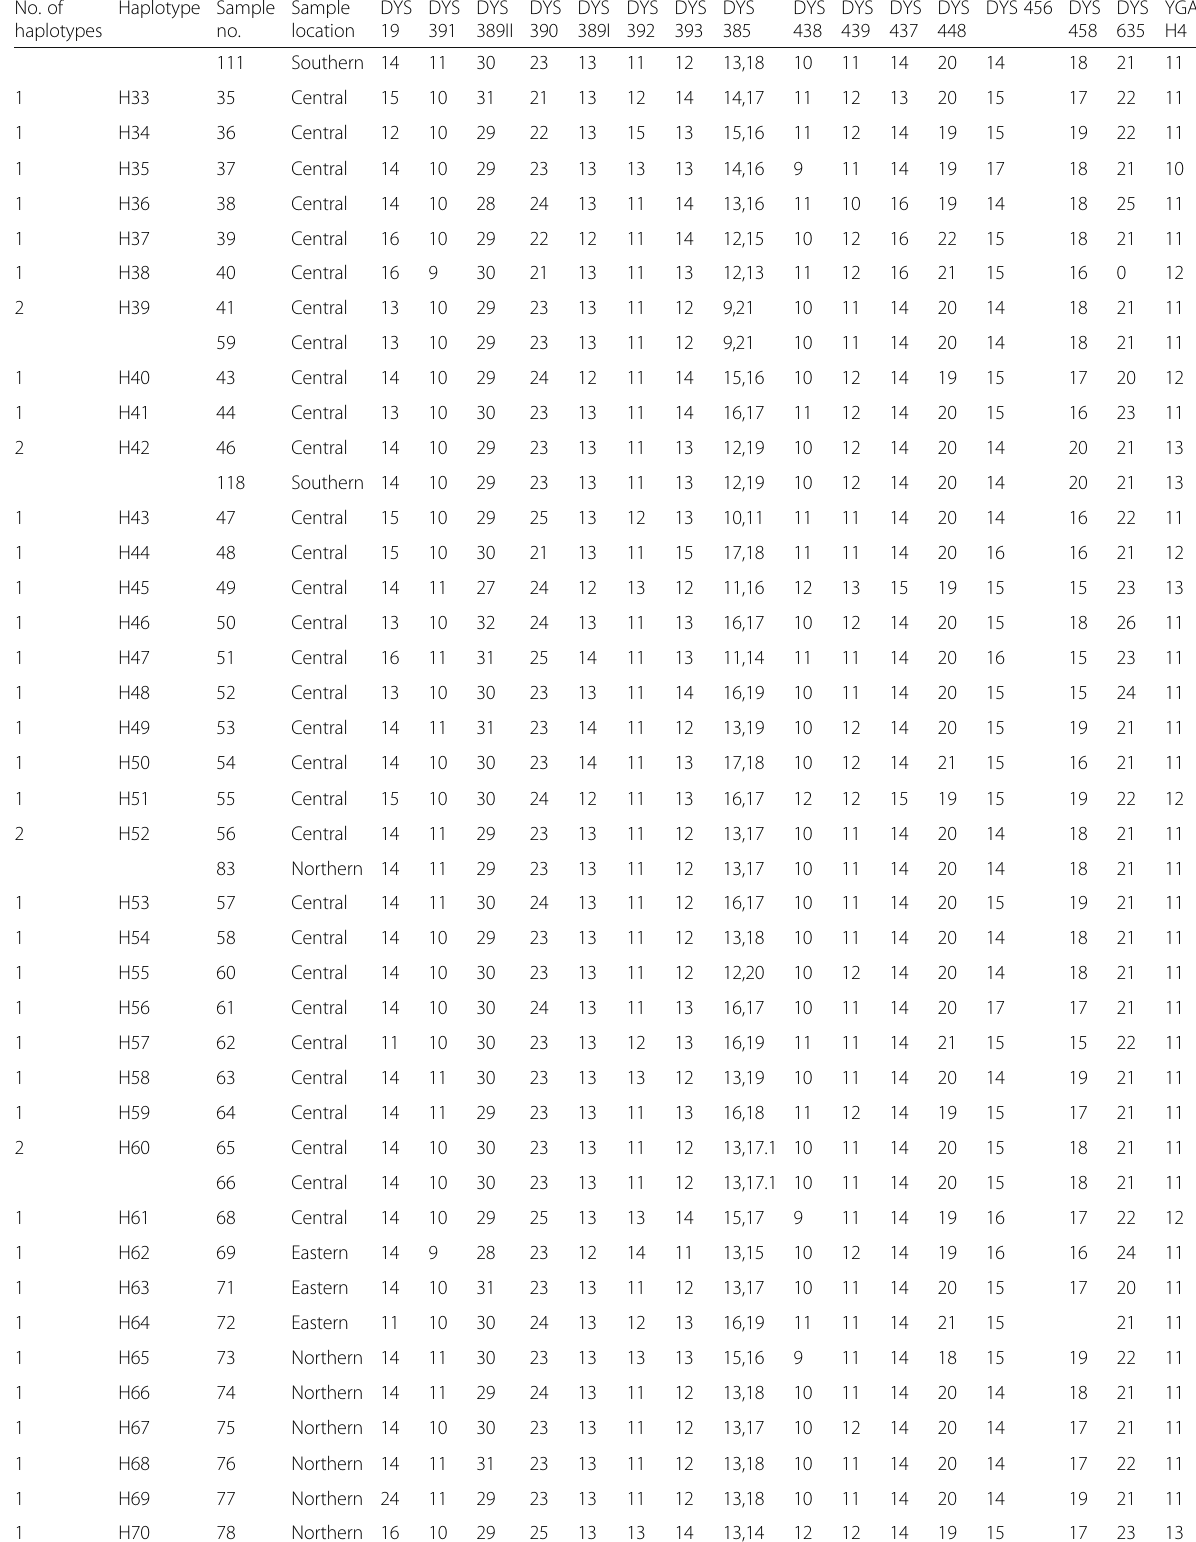
Table 2 Y chromosome haplotype analysis of 17-YSTR markers in male Saudi population ( n = 125) (Continued) No. of Haplotype Sample haplotypes